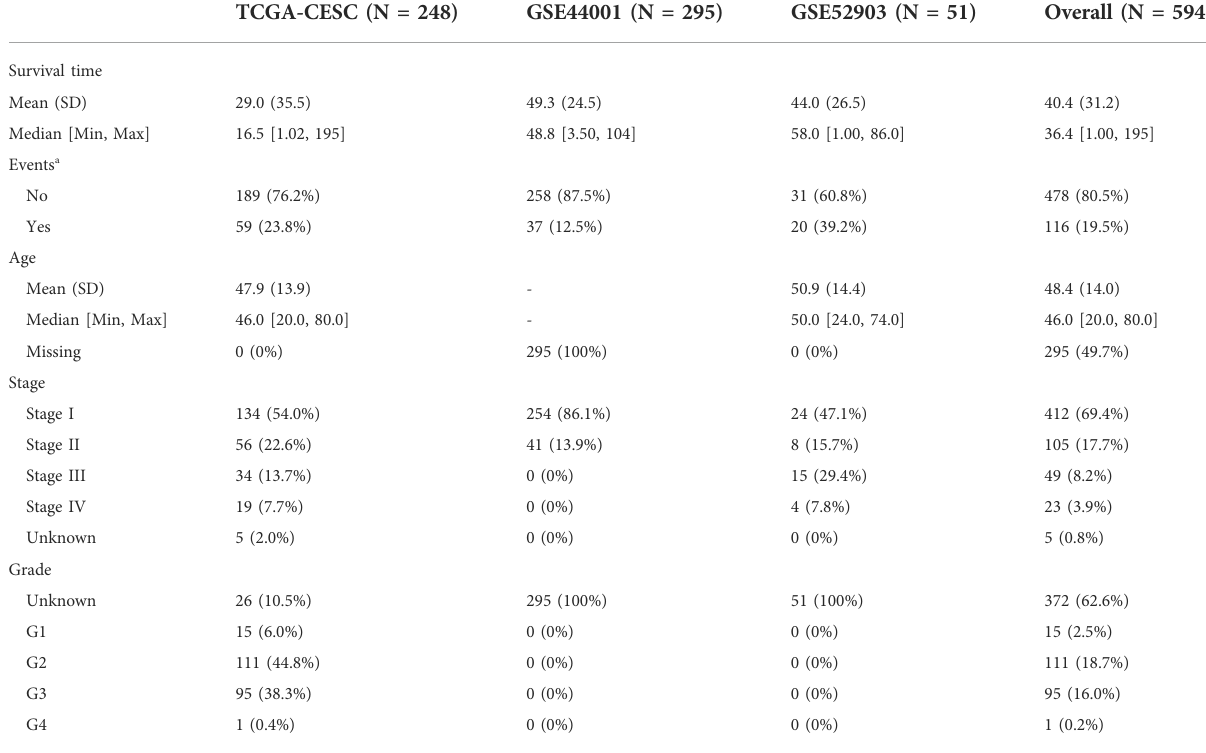
TABLE 1 Clinicopathological information of the enrolled